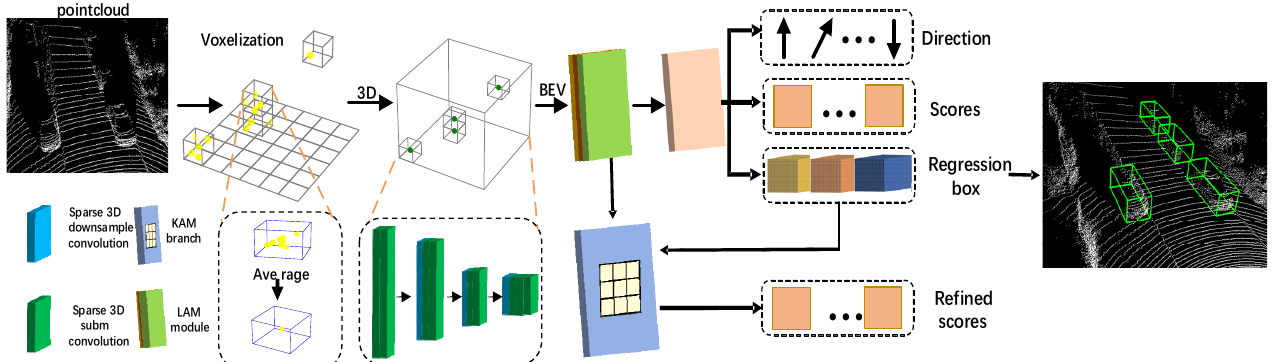
Figure 2. Overview of the KASSD. Firstly, the KASSD convert raw points to voxel features. Then, the 3D backbone module applies 3D sparse convolution for feature extraction. Subsequently, the 3D features are converted into BEV representations, on which we use the LLM module to obtain more expressive features for subsequent detection. Finally, the KAM take regression box is used as input